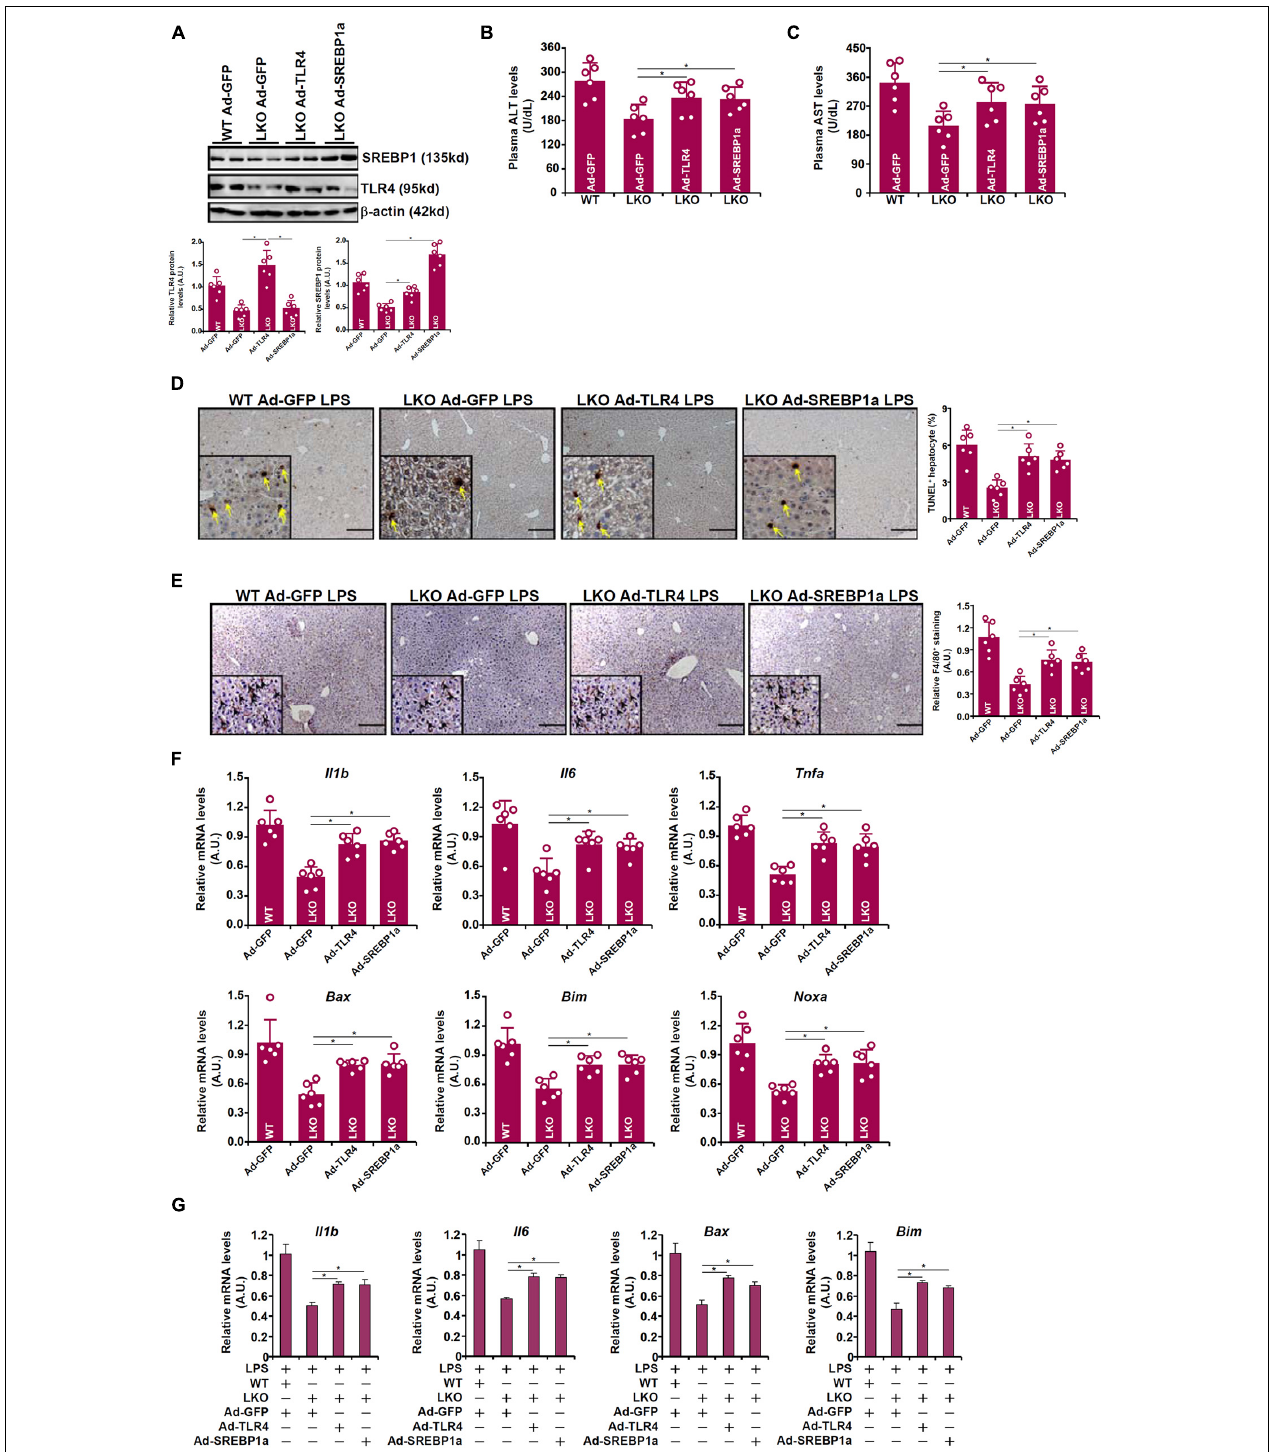
FIGURE 5 | TLR4 over-expression or SREBP1a over-expression restores liver injury in BRG1 deficient mice. (A–F) WT and BRG1 LKO mice were injected via tail veinadenovirus carrying either TLR4 (Ad-GFP-TLR4), SREBP1a (Ad-GFP-SREBP1a), or GFP (Ad-GFP). 2 week later, the mice were injected with injected peritoneally with LPS (15 mg/kg) and sacrificed 24 h after the injection. Gene expression levels were examined by Western (A) . Plasma ALT levels (B) . Plasma AST levels (C) . Paraffin sections were stained with F4/80 (D) . Paraffin sections were stained with TUNEL (E) . Gene expression levels were examined by qPCR (F) . N = 6 mice for all groups. (G) Primary hepatocytes were isolated from WT or BRG1 LKO mice and transduced with indicated andenoviral particles. The cells were with LPS (1 µ g/ml) for 12 h and gene expression was examined by qPCR.